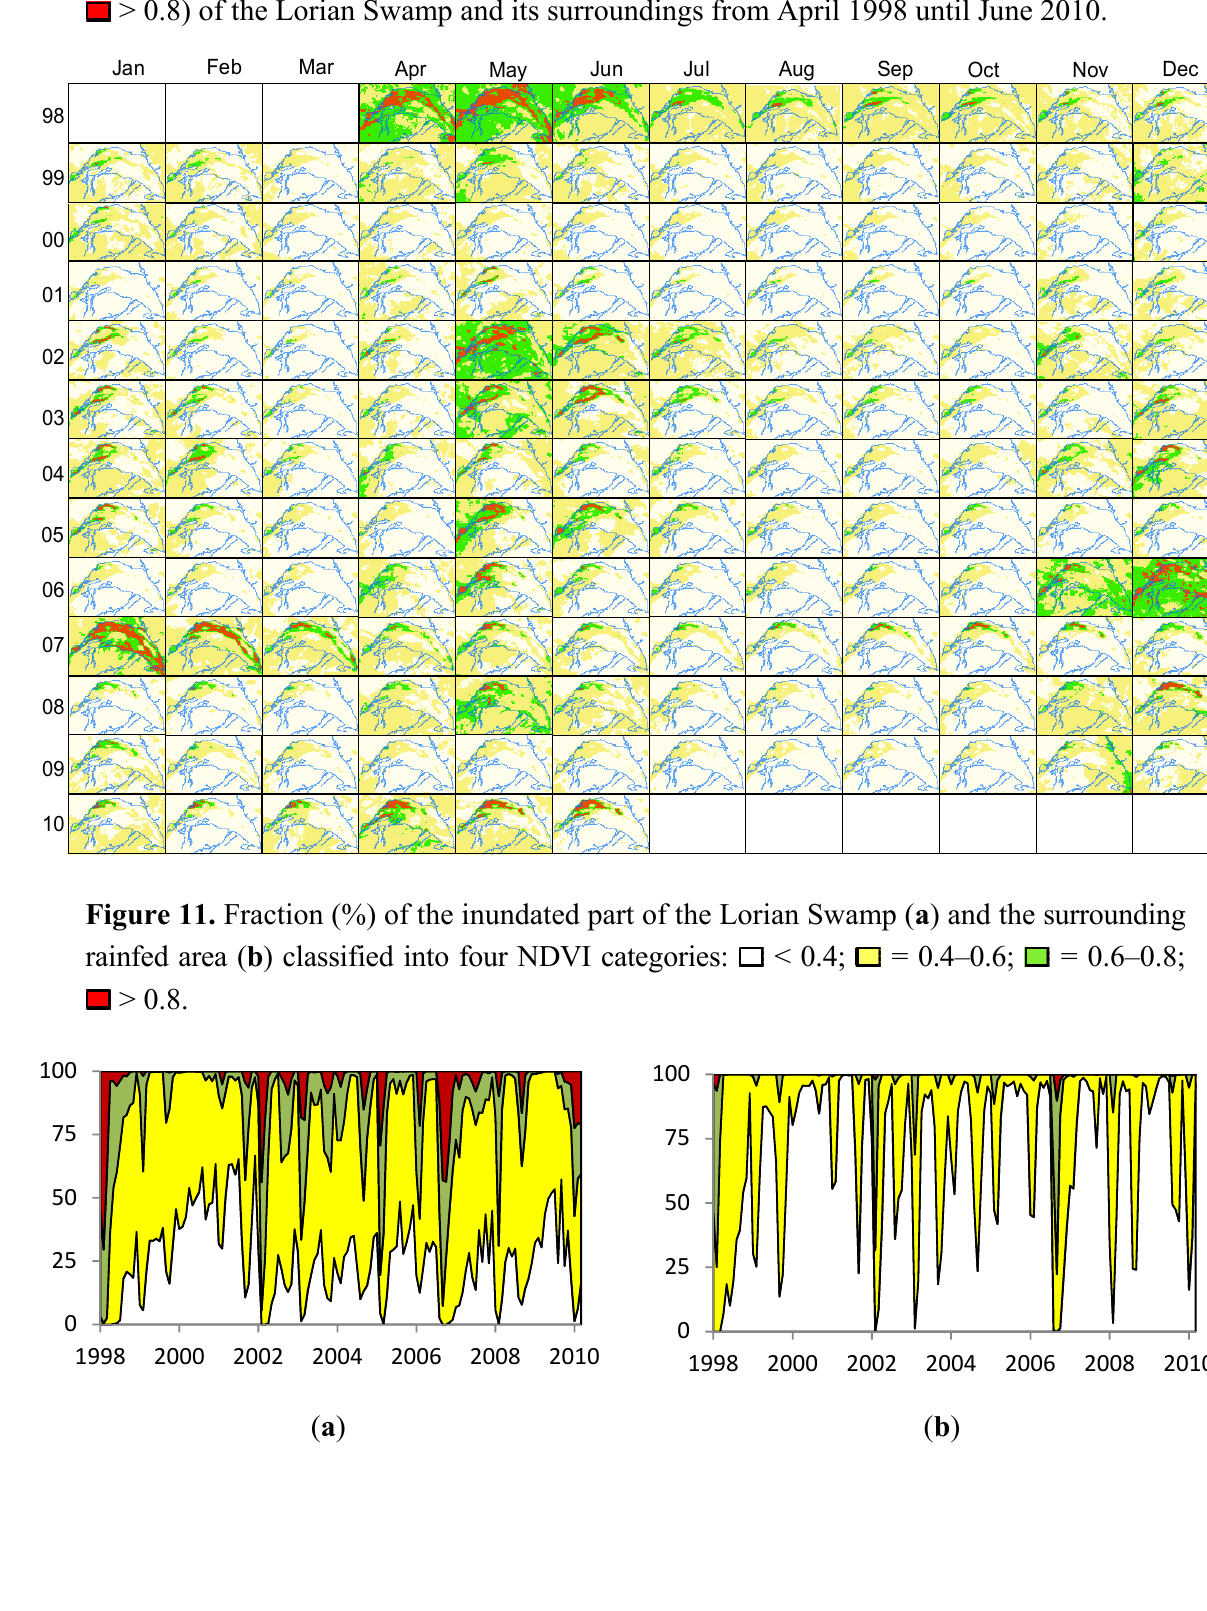
Figure 10. Monthly SPOT VEGETATION NDVI (